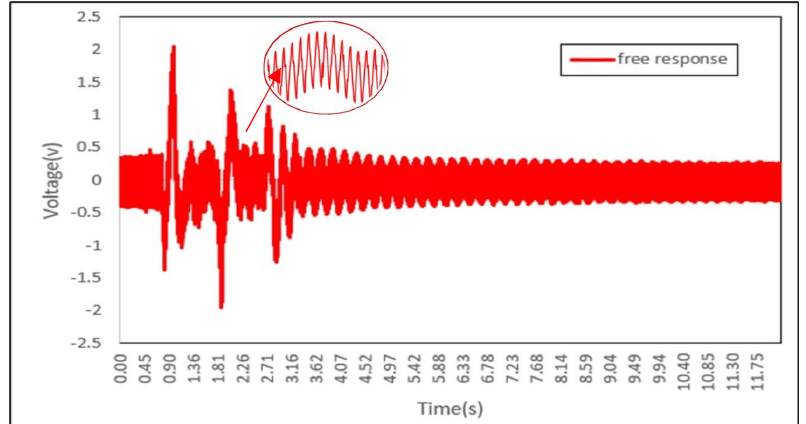
Fig. 7. Vibration Response of the First Link without active control FLC.